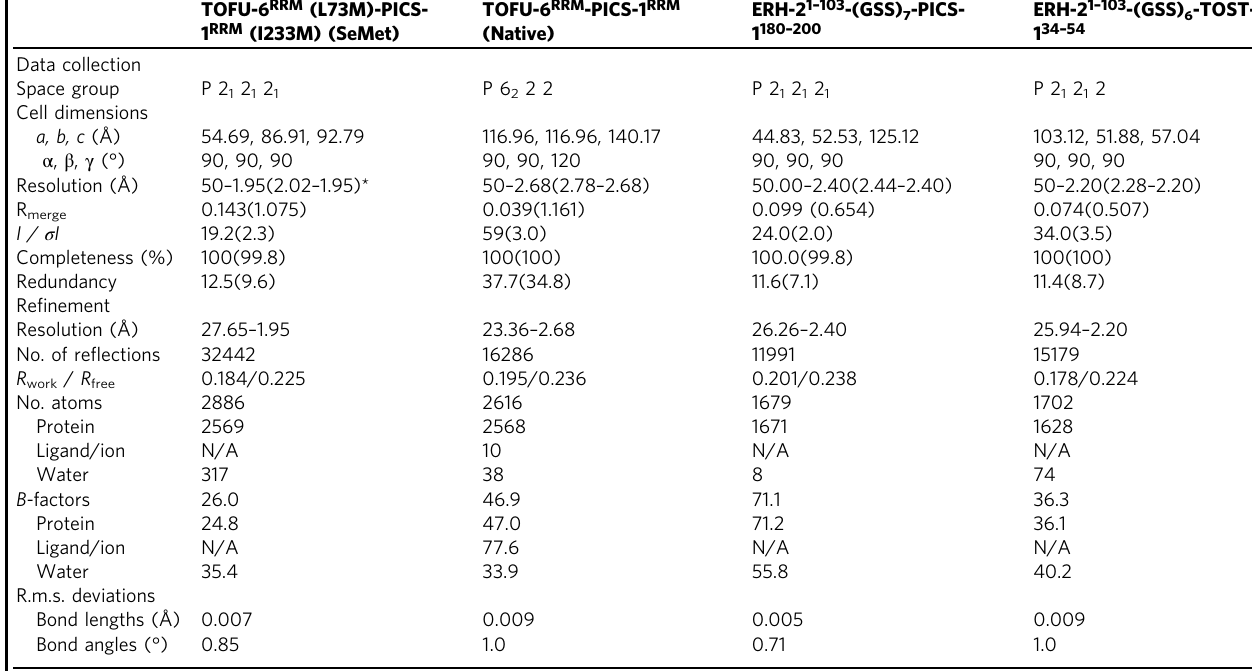
Table 1 Data collection and re fi nement statistics. TOFU-6 RRM